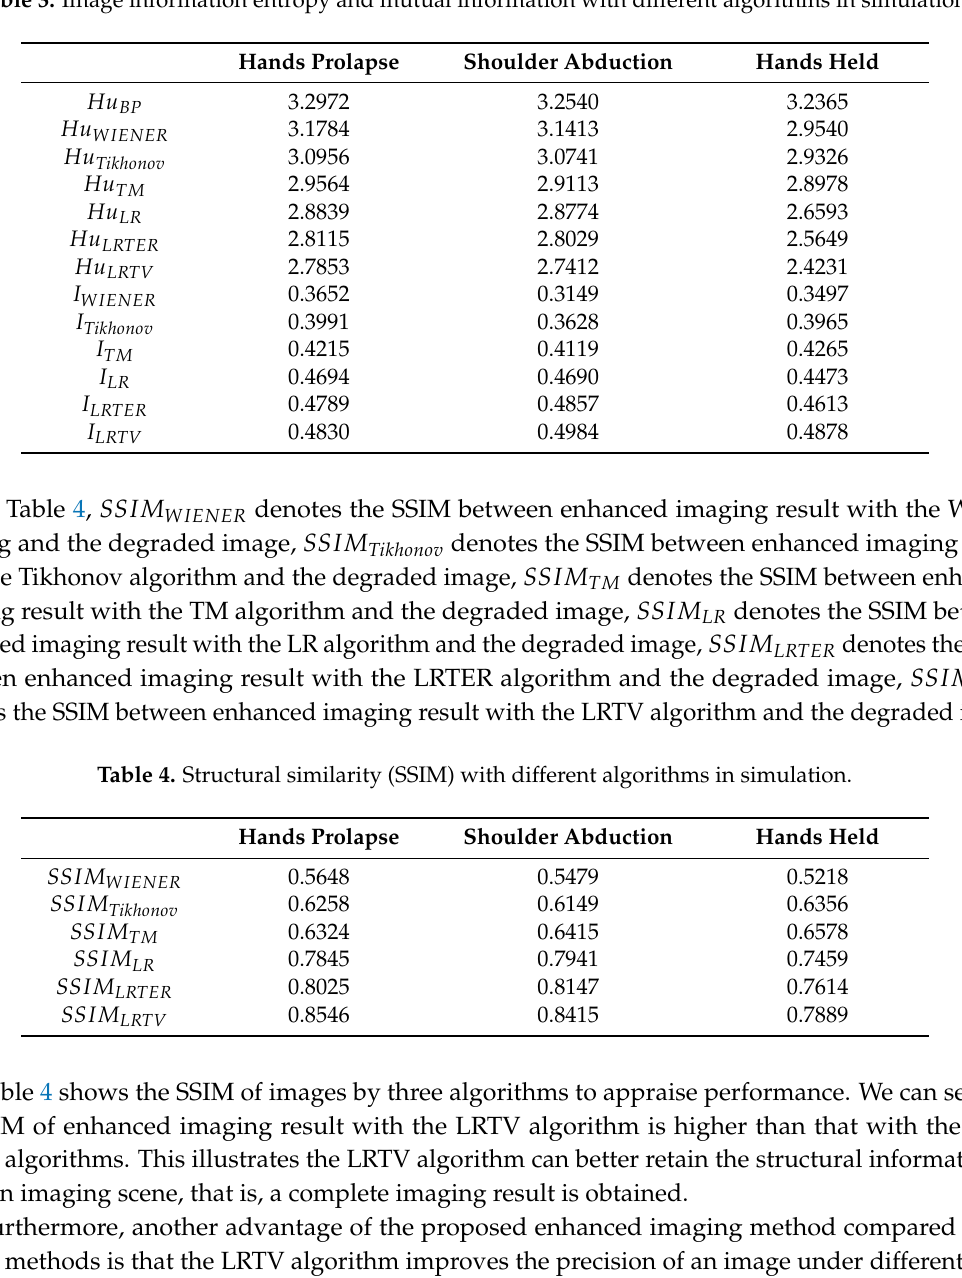
Table 3. Image information entropy and mutual information with different algorithms in simulation.